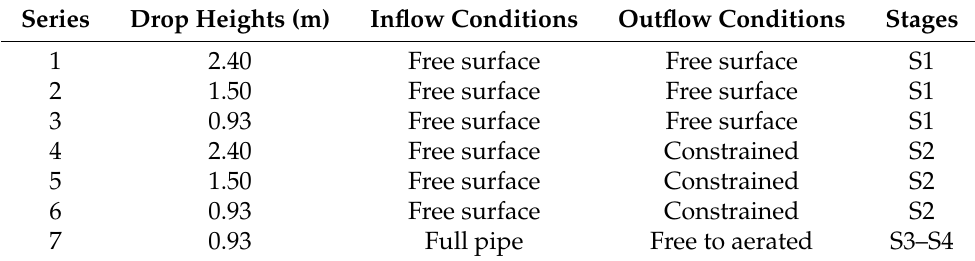
Table 2. List of experiments.